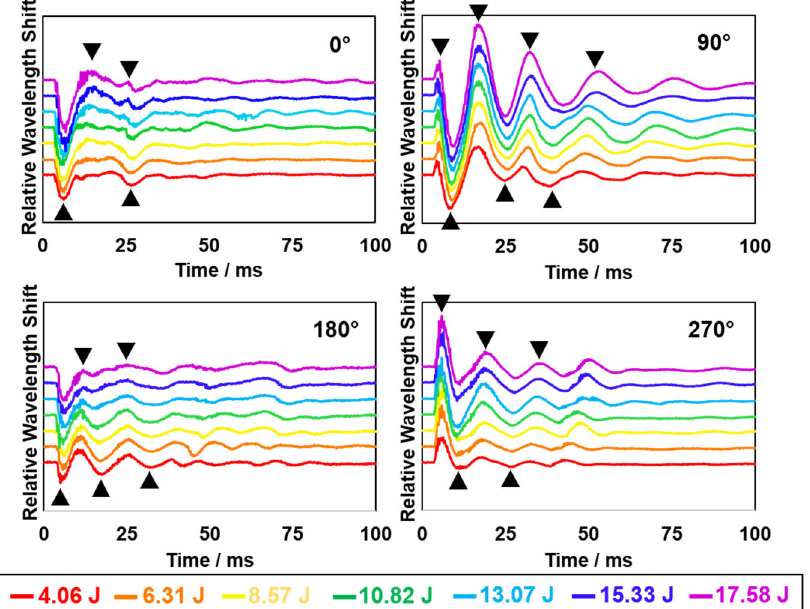
Figure 3. First 100 ms of the transient oscillatory signals resulting from pendulum impacts for four selected directions (0 ◦ , 90 ◦ , 180 ◦ and 270 ◦ ) and seven different kinetic energy levels from 4.06 J to 17.58 J). Black arrows indicate typical spectral peaks and valleys that may serve as the “fingerprint” features for a specific impact condition.